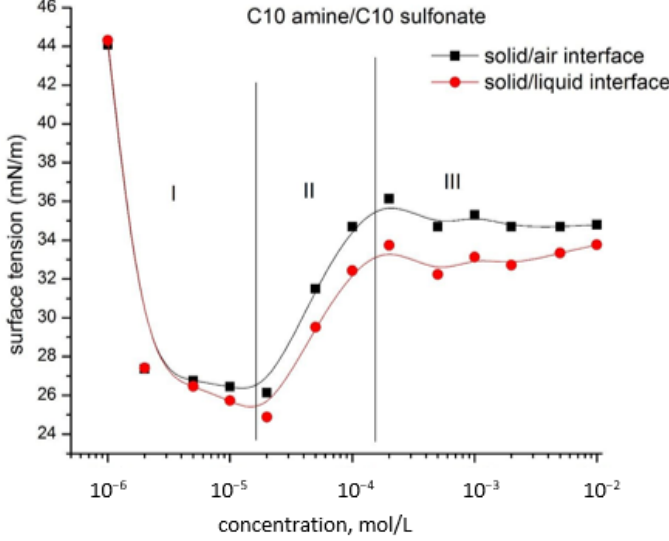
Figure 5. Surface tension of liquid/air and solid/air interface for C10 amine/C10 sulfonate mixture.